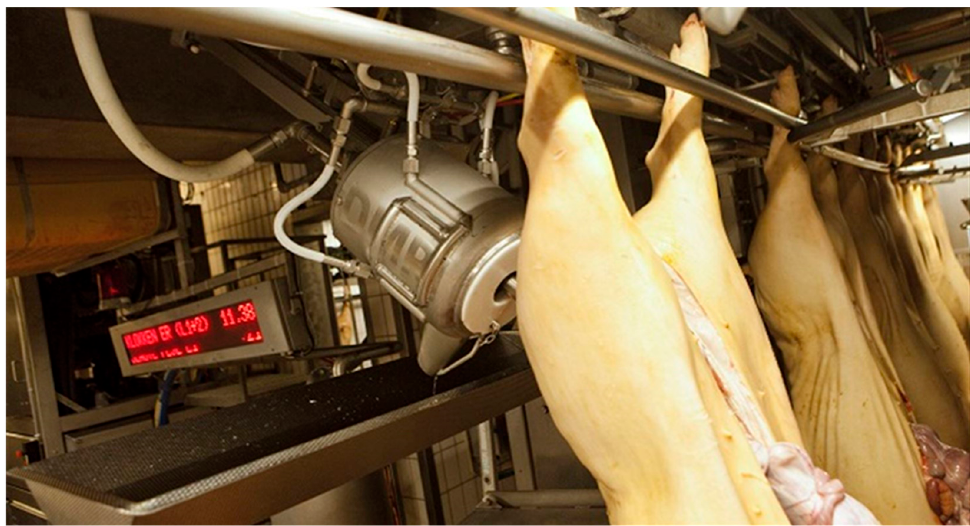
Figure 2. The DMRI bung dropper [34] (Reprinted, with permission from DMRI, Danish Technological Institute).